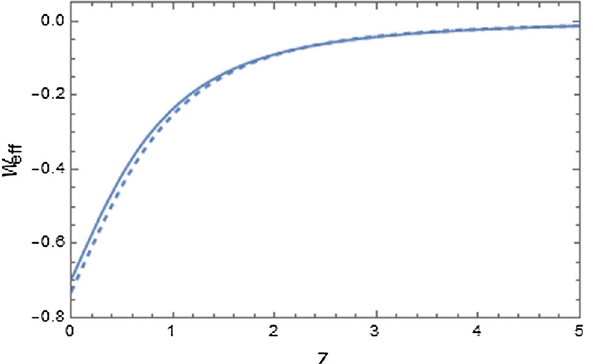
Fig. 6 Hereweplotthetotalequationofstateforourmodel(continuos line) in comparison to that of the LCDM model (dashed